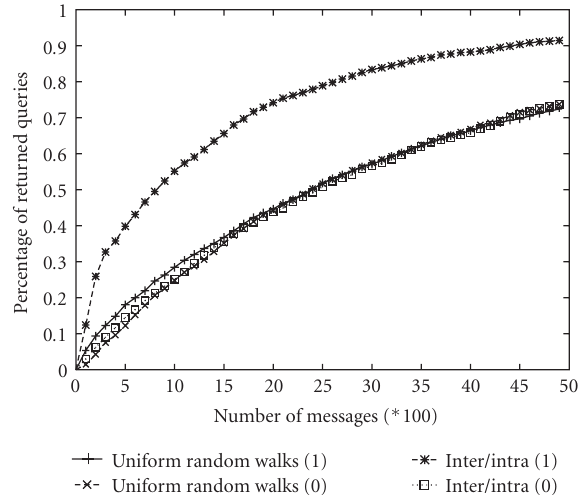
Figure 10: The percentage of returned query within a specific mes- sage number in a less-clustered